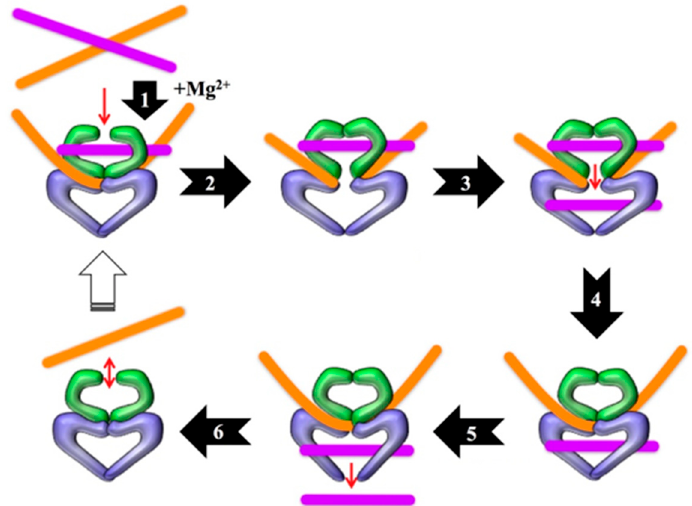
Figure 1. Catalytic cycle of type II topoisomerases. Step 1: The enzyme bends the gate-, or G-, segment of DNA in the presence of divalent metal ions (the physiological ion is Mg 2+ ). Step 2: The enzyme cleaves and covalently attaches to the newly generated 5’-termini of the G-segment, generating the cleavage complex. Step 3: The enzyme passes the transfer-, or T-, segment of DNA through the cut it generated in the G-segment. Step 4: The enzyme religates the G-segment. Step 5: The T-segment is released from the enzyme. Step 6: The enzyme releases the G-segment and resets for another round of catalysis. Note that ATP hydrolysis is required for the enzyme to complete the catalytic cycle. Modified from Reference [22].